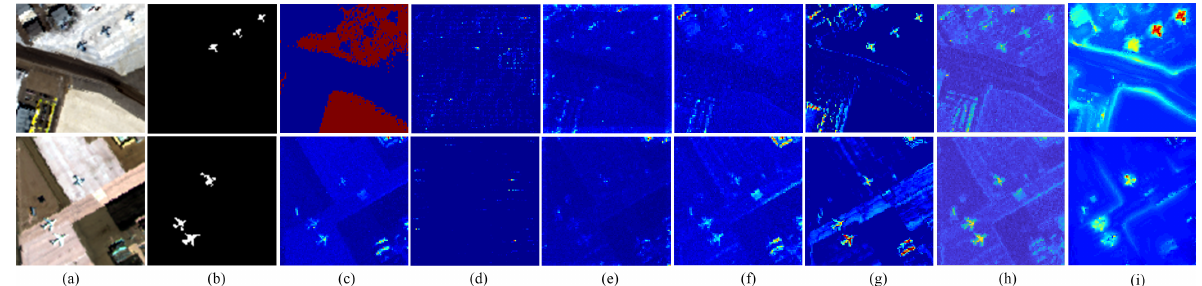
Figure 6. Detection maps of the compared AD methods. The sample images from top to bottom are AVIRIS-1, and AVIRIS-2, respectively. ( a ) Color composites of urban scene; ( b ) Reference map;